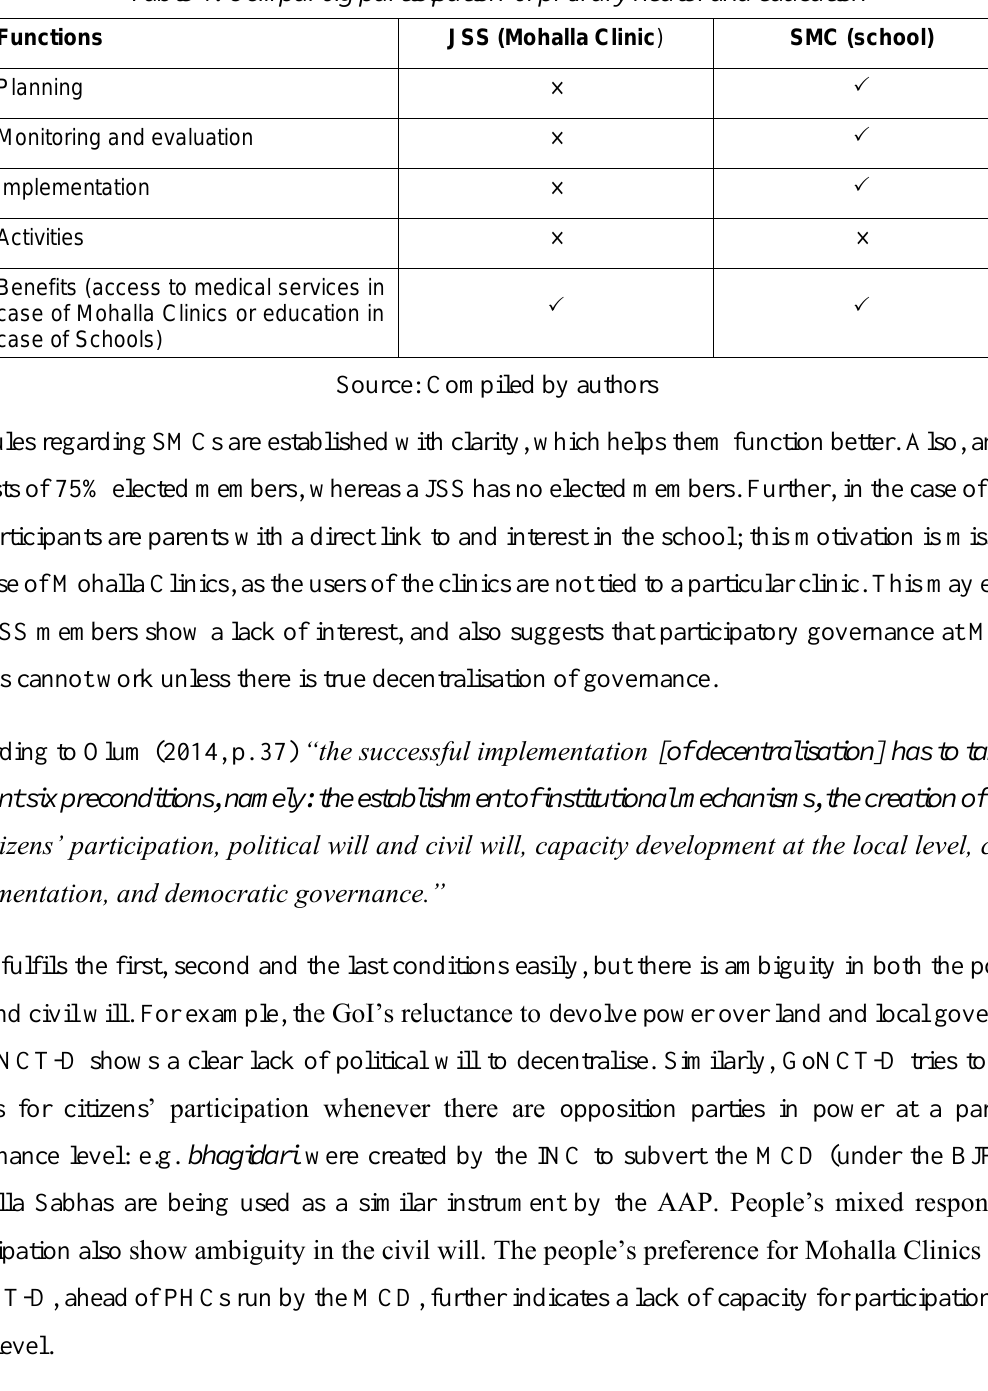
Table 4: Comparing participation in primary health and